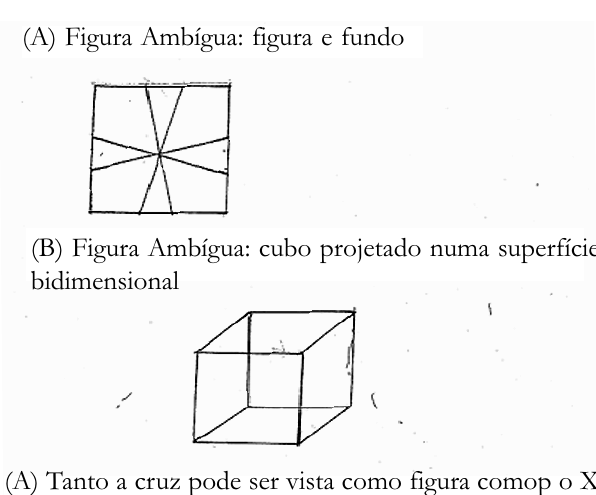
figuras.(A) Figura Amb(cid:237)gua: figura e fundo